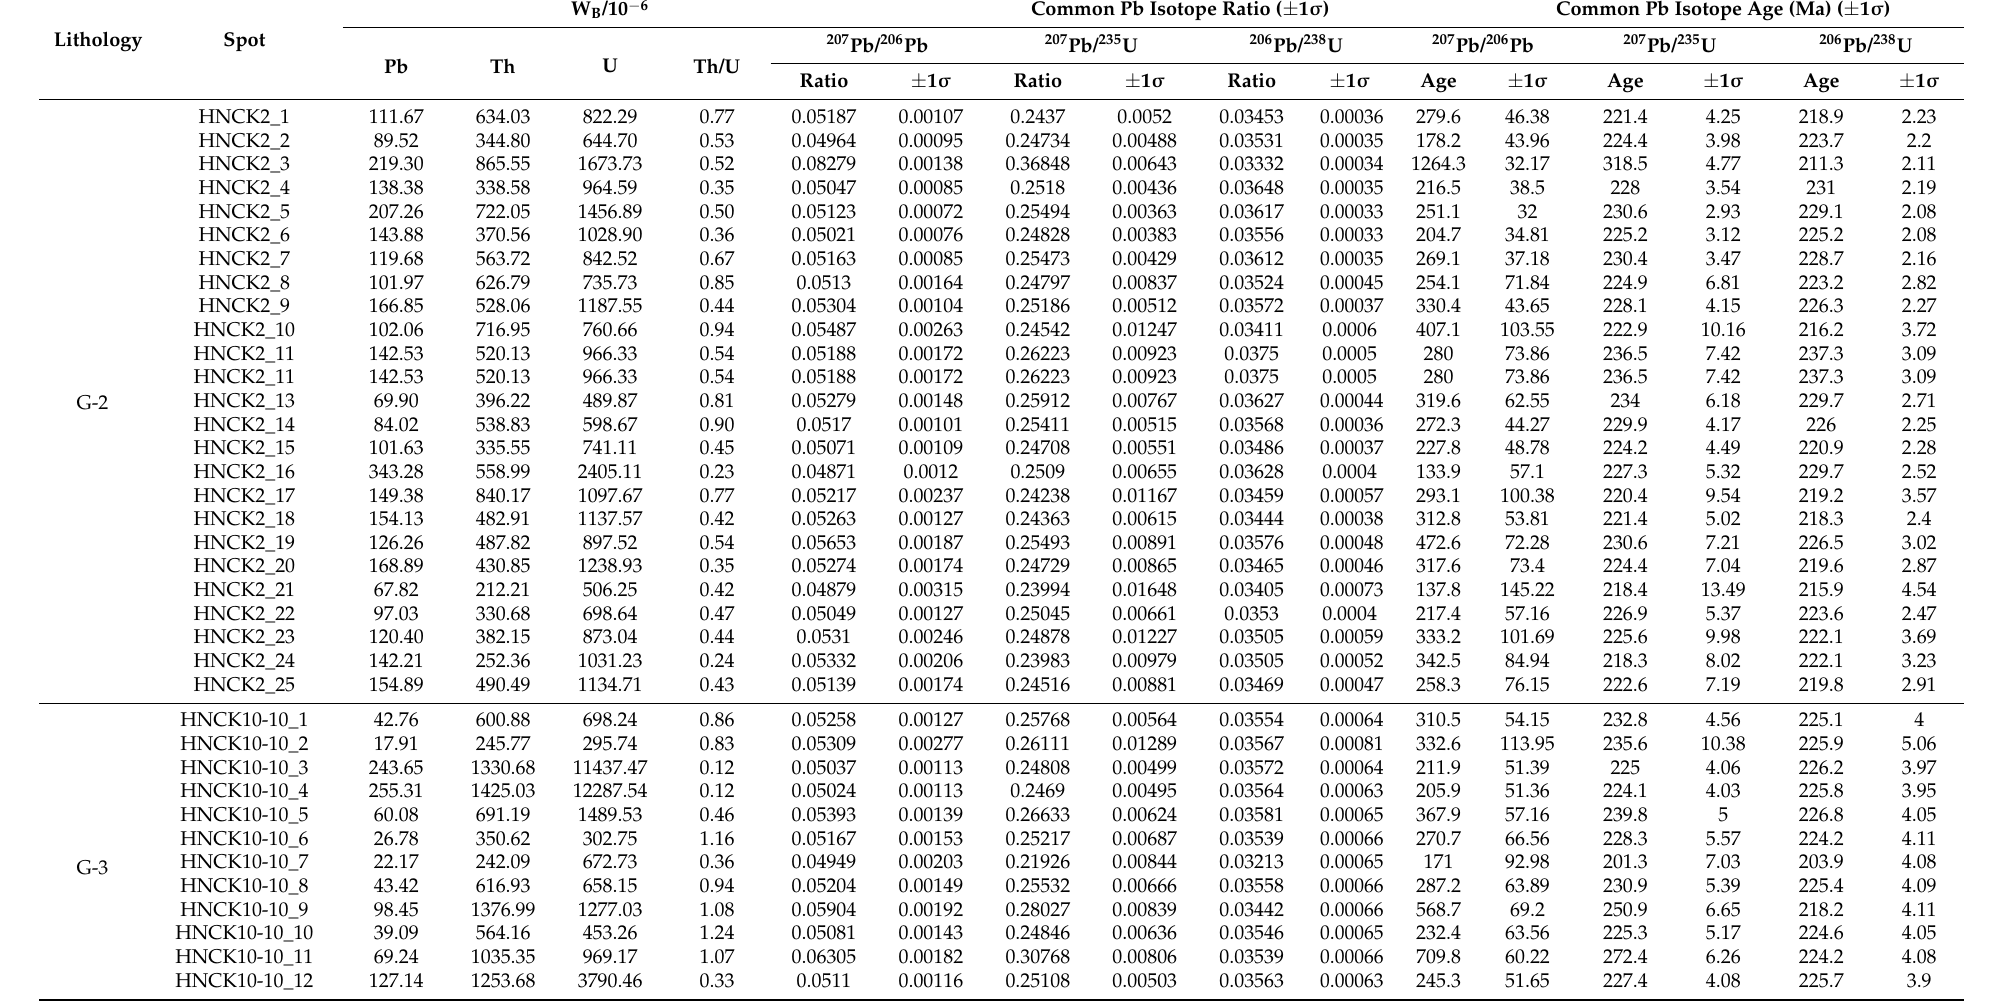
Table 2. The LA-ICP-MS U-Pb analysis results of zircons from granitoids from Chuankou ore